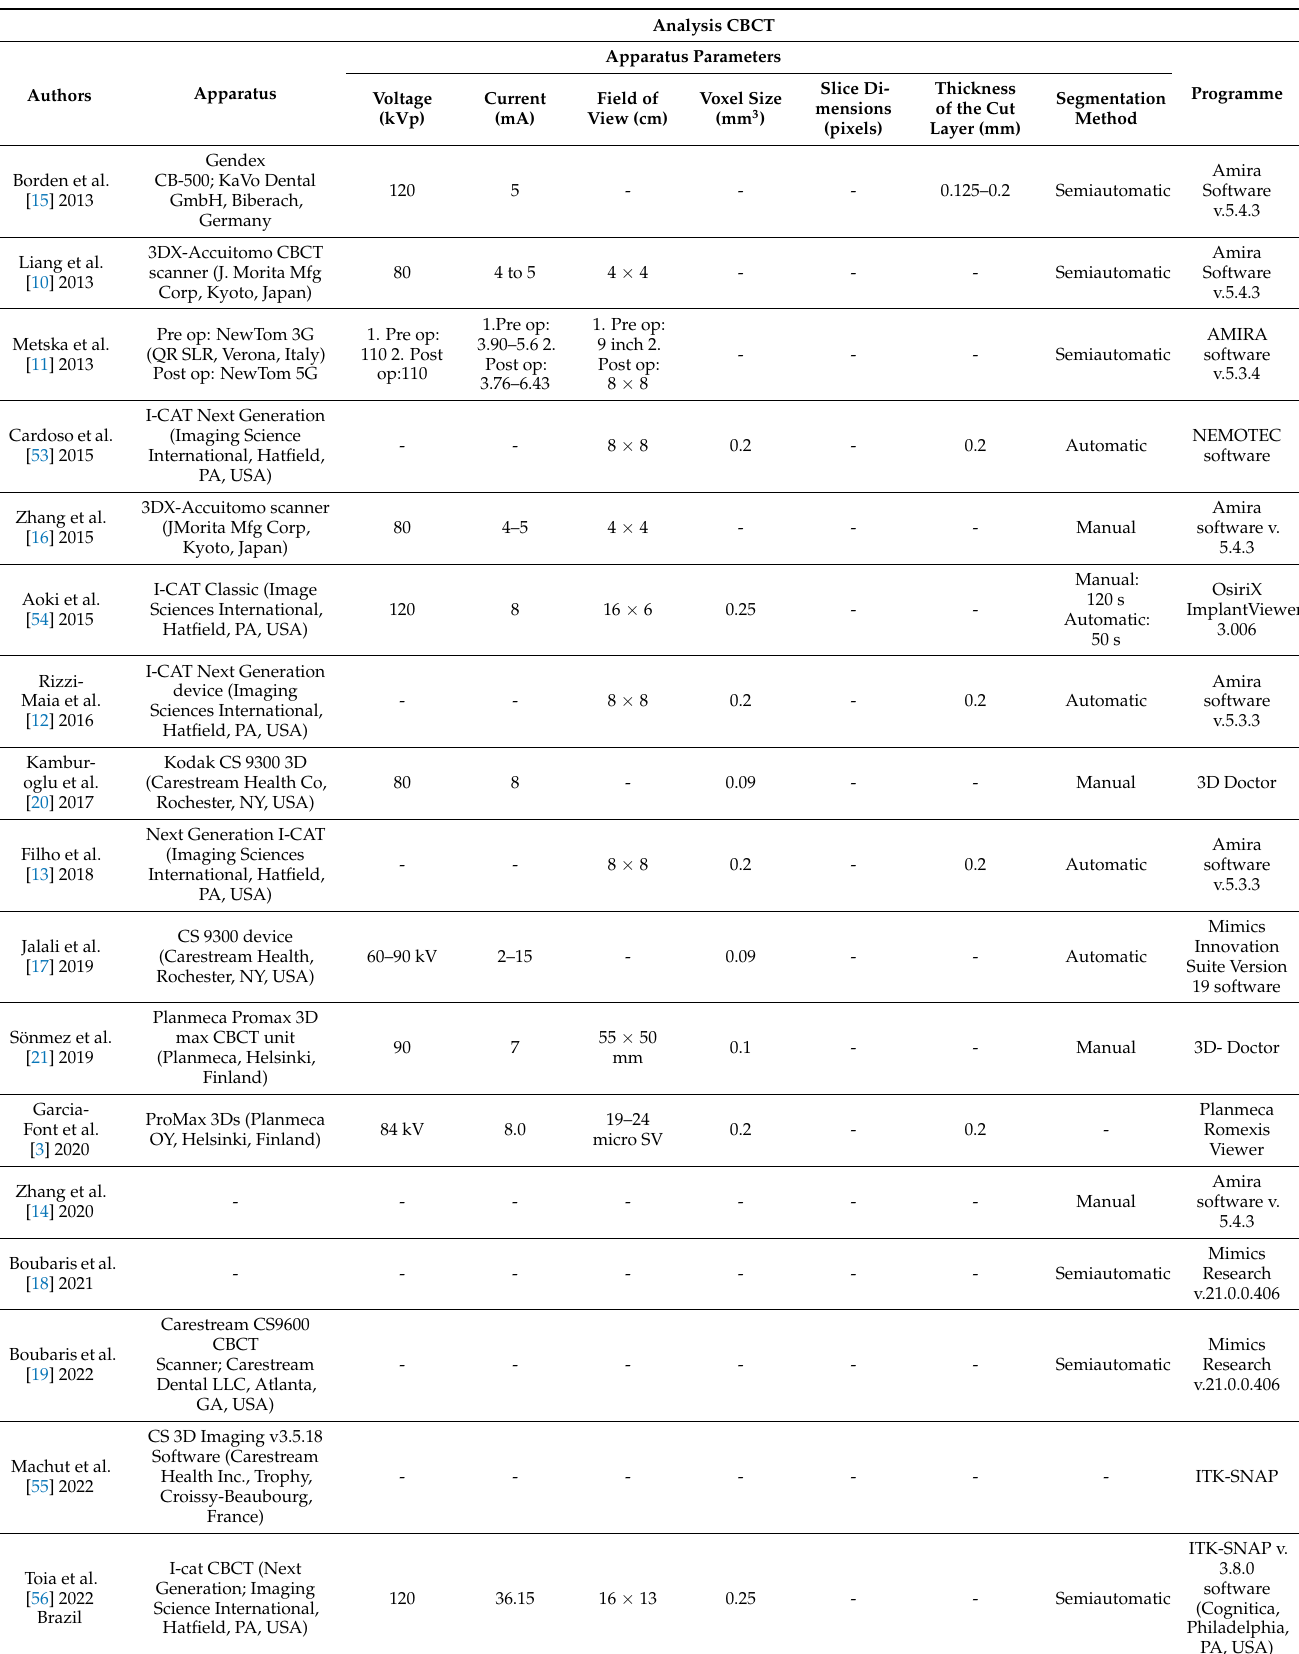
Table 3. The most important parameters of the CBCT apparatus are from included studies. Analysis